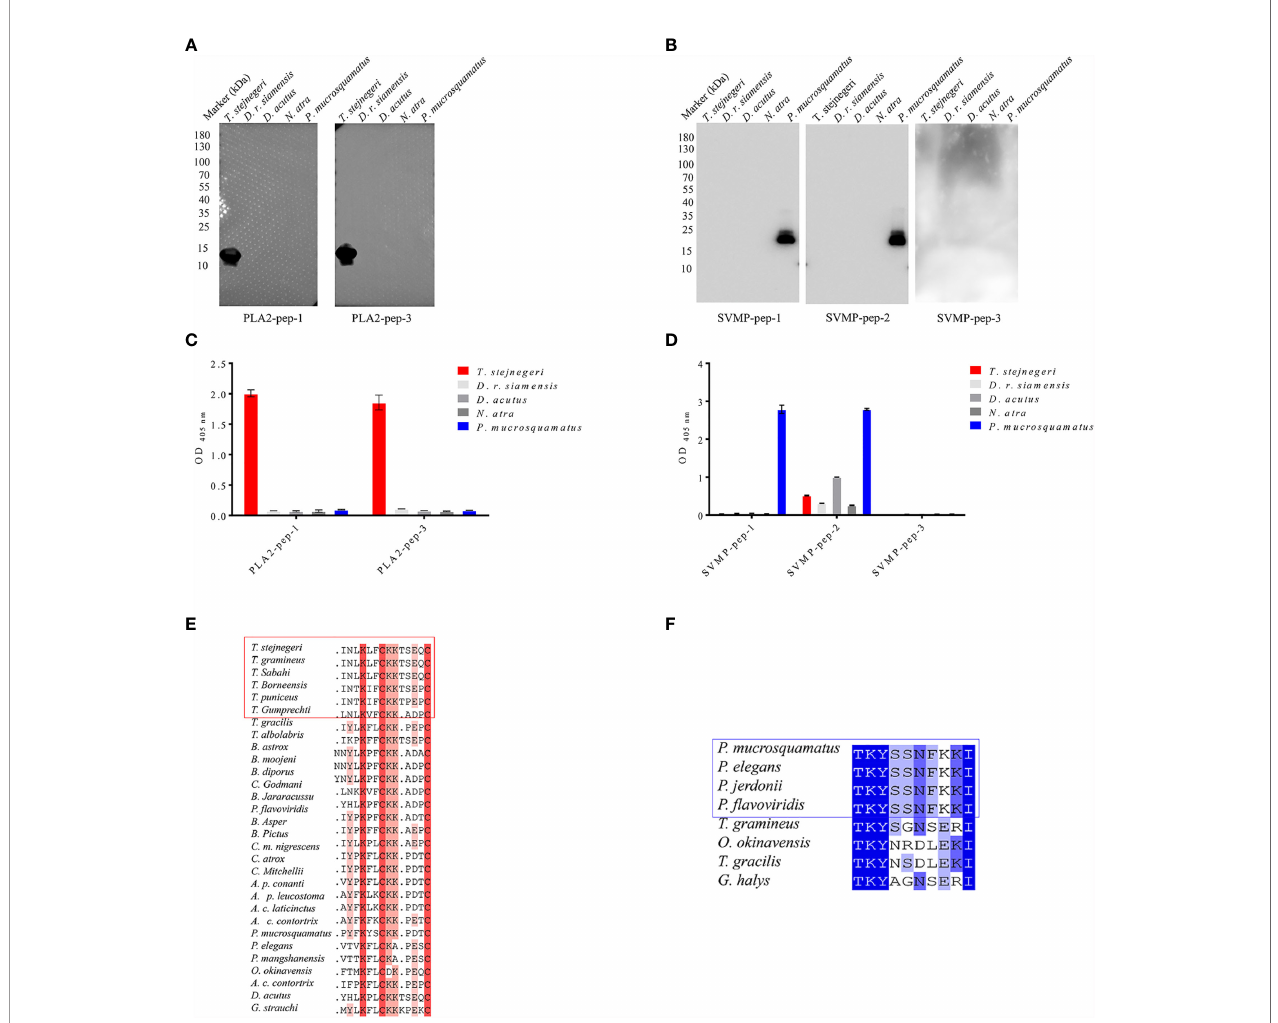
FIGURE 3 | Accessibility and speci fi city of peptide antigens. Based on Western blot analysis, anti-PLA2-pep-1, anti-PLA2-pep-3, anti-SVMP-pep-1, and anti-SVMP- pep-2 antibodies were speci fi c to the venom of fi ve species ( T. stejnegeri , D. r. siamensis , D. acutus , N. atra , and P. mucrosquamatus ) and showed single bands, while anti-SVMP-pep-3 showed no target band (A , B) . Antigen accessibility of peptide antigens in natural protein was determined based on ELISA of venom-coated plates. Results showed that PLA2-pep-1, PLA2-pep-3, SVMP-pep-1, and SVMP-pep-2 were surface accessible. Moreover, PLA2-pep-1, PLA2-pep-3, and SVMP- pep-1 showed species speci fi city, but SVMP-pep-2 showed low species speci fi city and cross-reactions with the other four snake venoms (C , D) . The sequence blast analysis of PLA2-pep-3 and SVMP-pep-1 showed that PLA2-pep-3 and SVMP-pep-1 have the best speci fi city in genus Trimeresurus and Protobothrops , respectively (E, F)